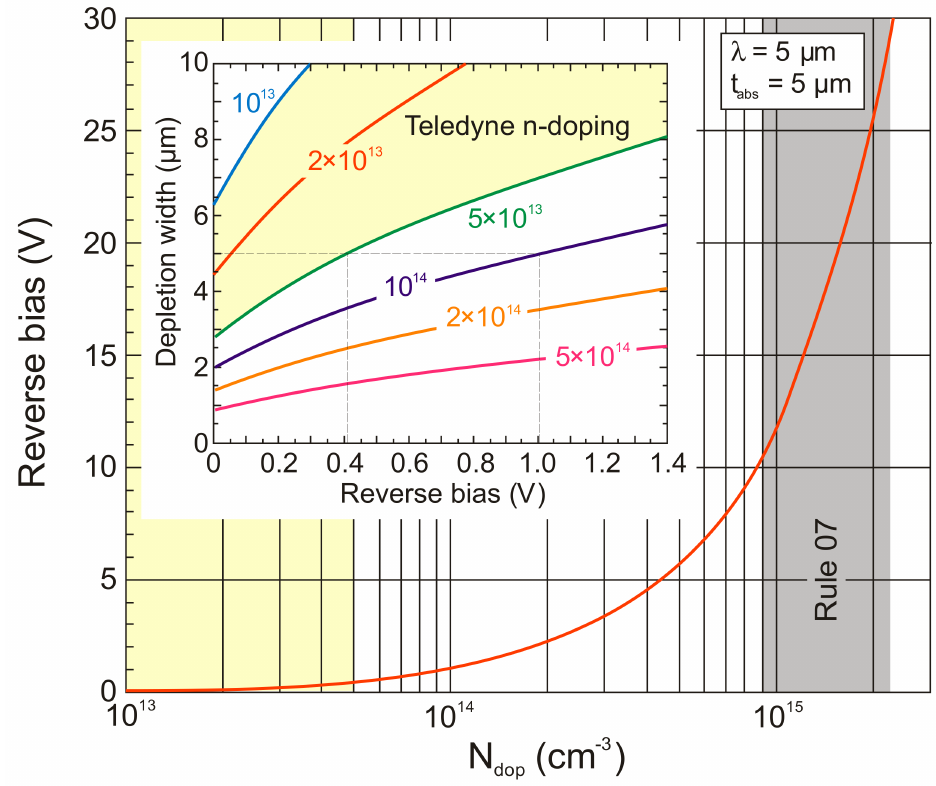
Figure 3. Calculated reverse voltage versus doping concentration required to deplete a 5- µ m-thick MWIR HgCdTe absorber. Inset: absorber depletion thickness versus reverse bias and selected doping